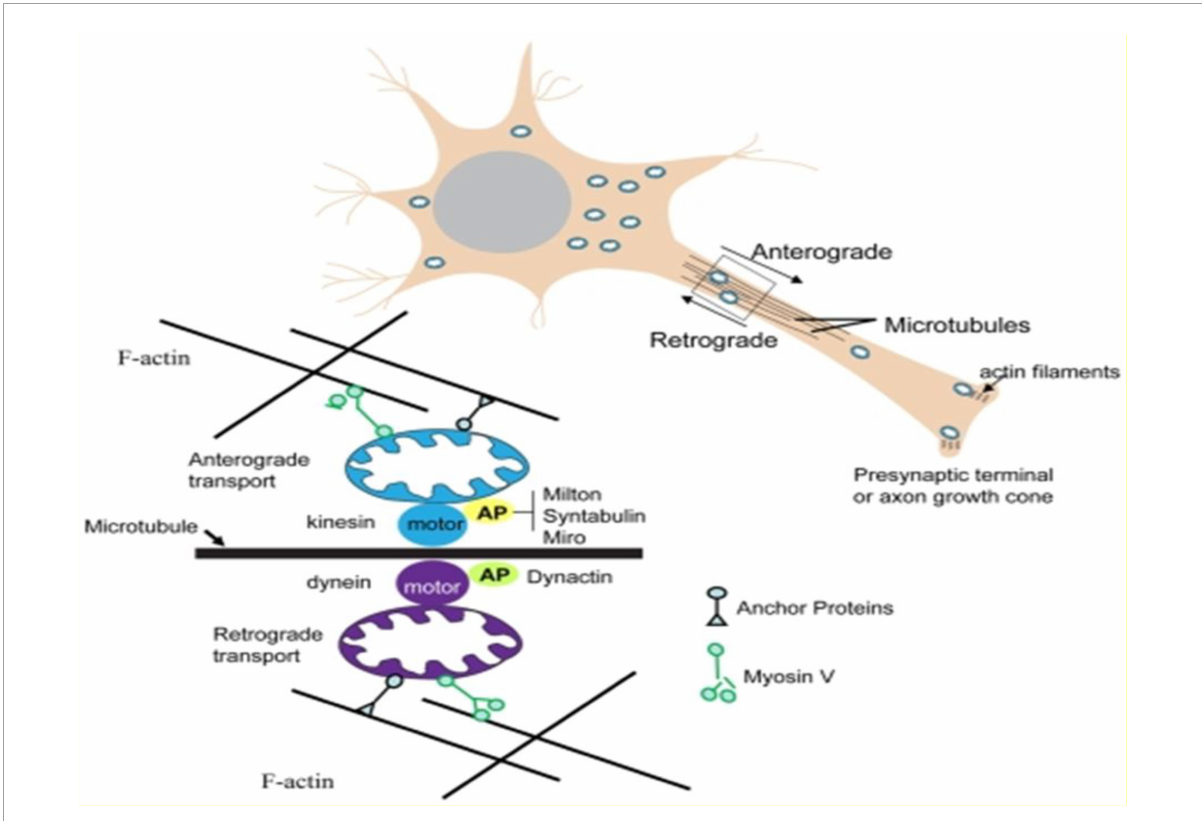
FIGURE3 Molecular machinery that actively moves mitochondria to and from within